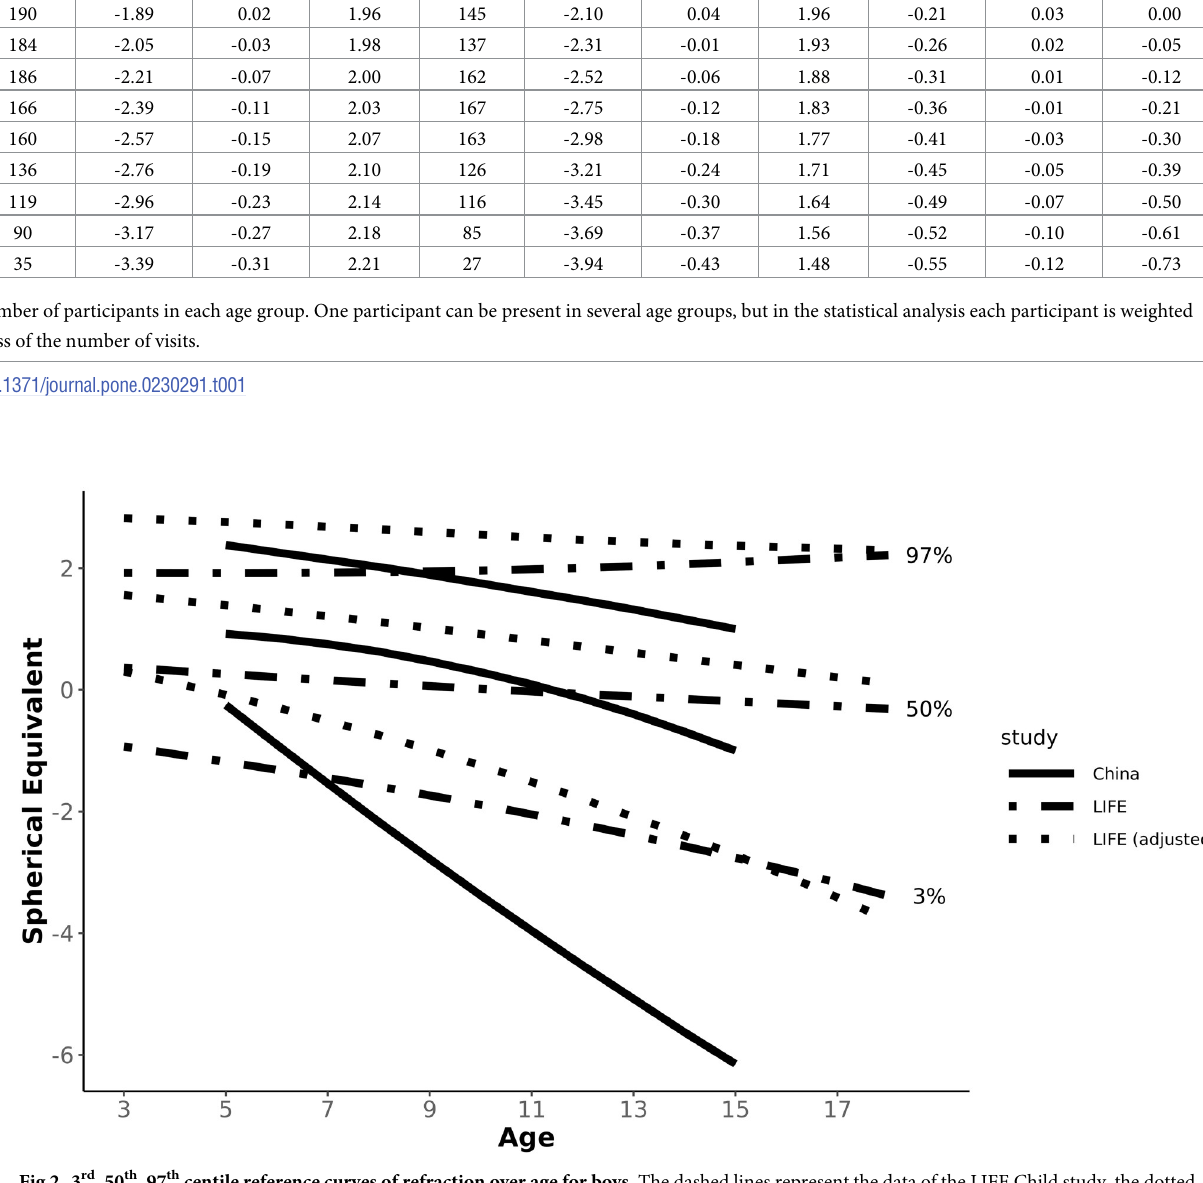
Fig 2. 3 rd , 50 th , 97 th centile reference curves of refraction over age for boys. The dashed lines represent the data of the LIFE Child study, the dotted lines the transferred data of LIFE Child study by the calculation of Sakaridurg et al. into comparable data for cycloplegia and the continous lines show the results of the RESC study from a city in China